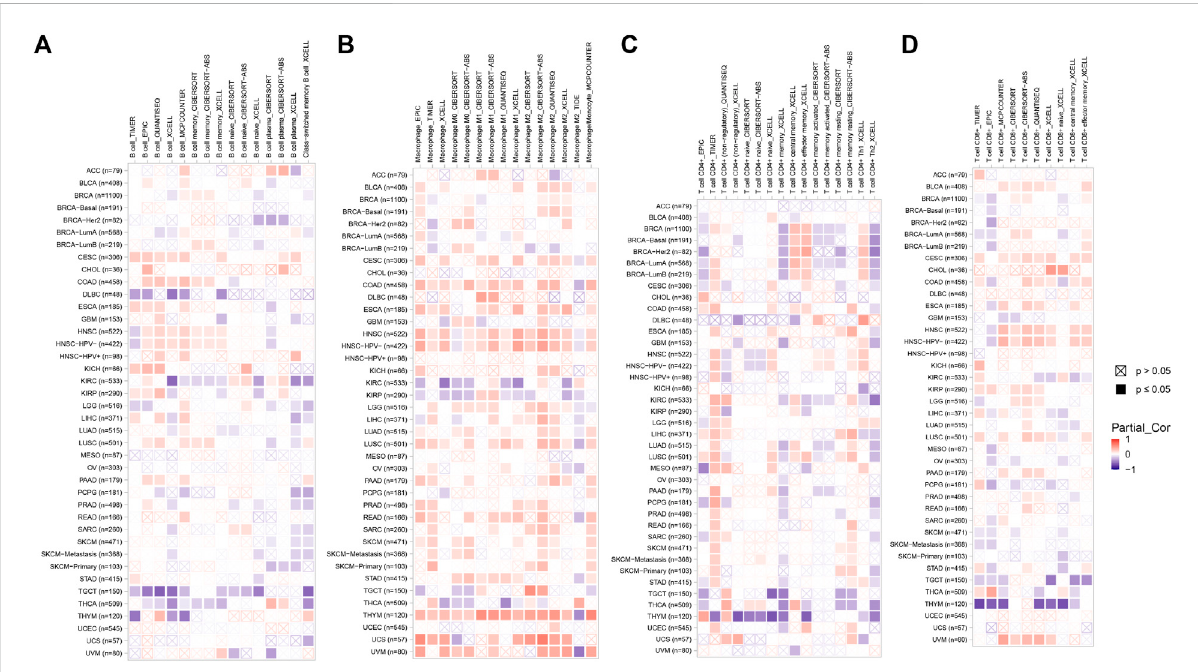
FIGURE 8 ThecorrelationofEXOC3L1 expression and immune cellin fi ltration. (A – D) Heatmapsofcorrelations between EXOC3L1 expressionandBcells, macrophages, T cell CD4 + , and T cell CD8 + in TIMER2 database,